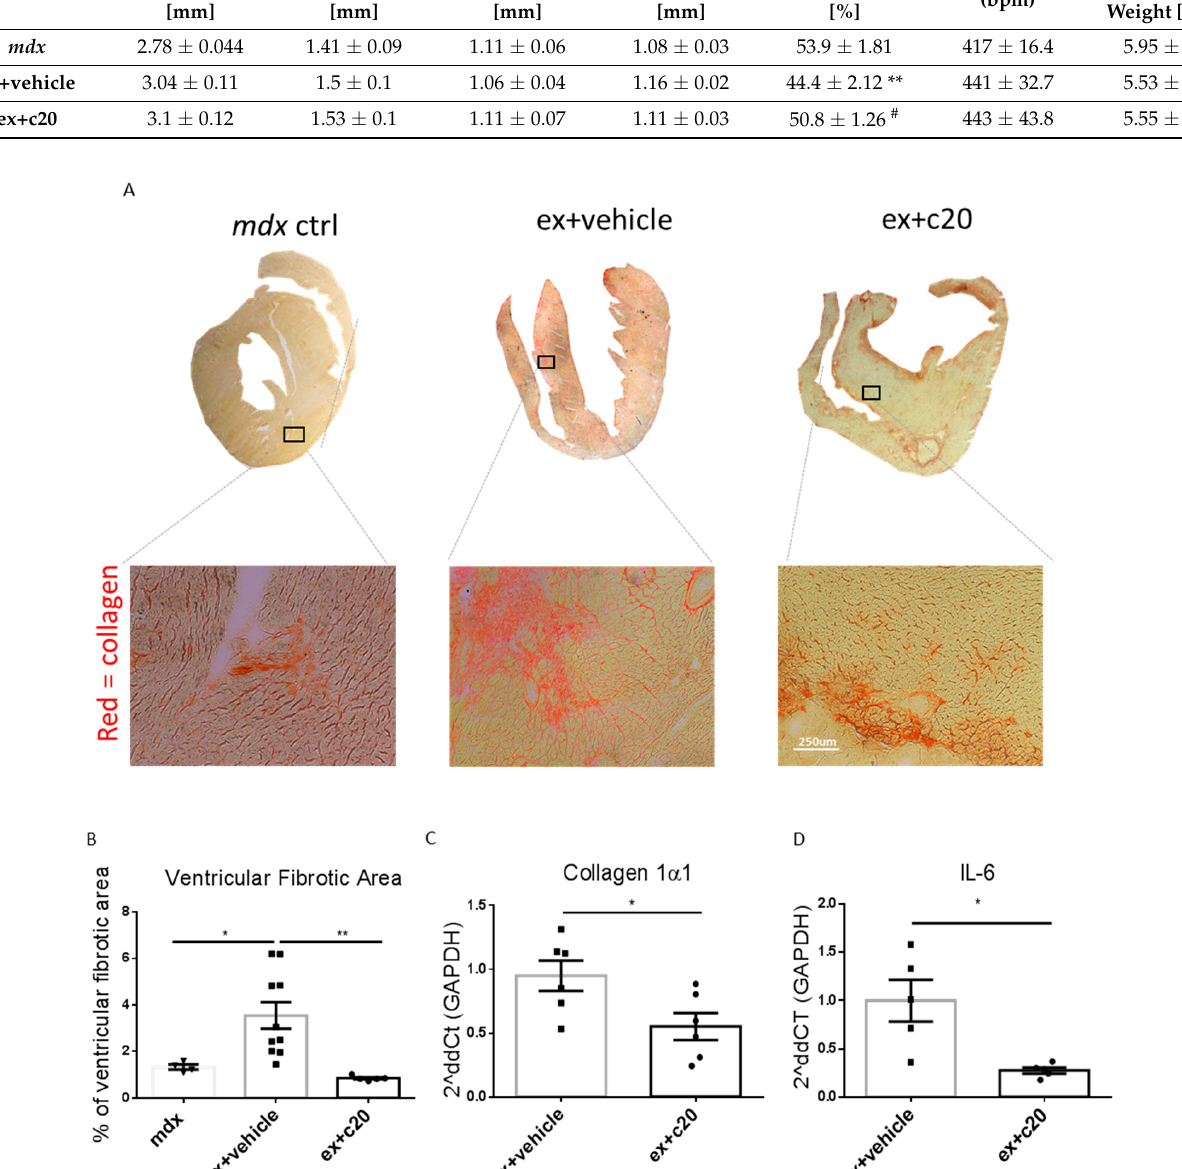
Figure 5. Decreased fibrotic tissue deposition in C20-treated exercised mdx ventricles. ( A ) Repre- sentative images of ventricular fibrosis in the hearts of control mdx vehicle-treated or C20-treated exercised mdx mice, evidenced by Sirius red collagen staining. ( B ) Quantification often ventricular fibrotic area over the total ventricular area expressed as percentage and calculated by ImageJ Colour Deconvolution plugin. n = 5, 10, 5 independent samples per group. * p < 0.05, ** p < 0.01, ordinary one-way ANOVA with Bonferroni correction for multiple comparisons. ( C , D ) qRT-PCR on total heart RNA for Collagen1 α ( n = 6 independent samples per group) and IL-6 mRNA ( n = 5 independent samples per group). * p < 0.05, unpaired t-test w/Welch’s correction. Data from ( B , D ) are shown as mean +/ − S.E.M.